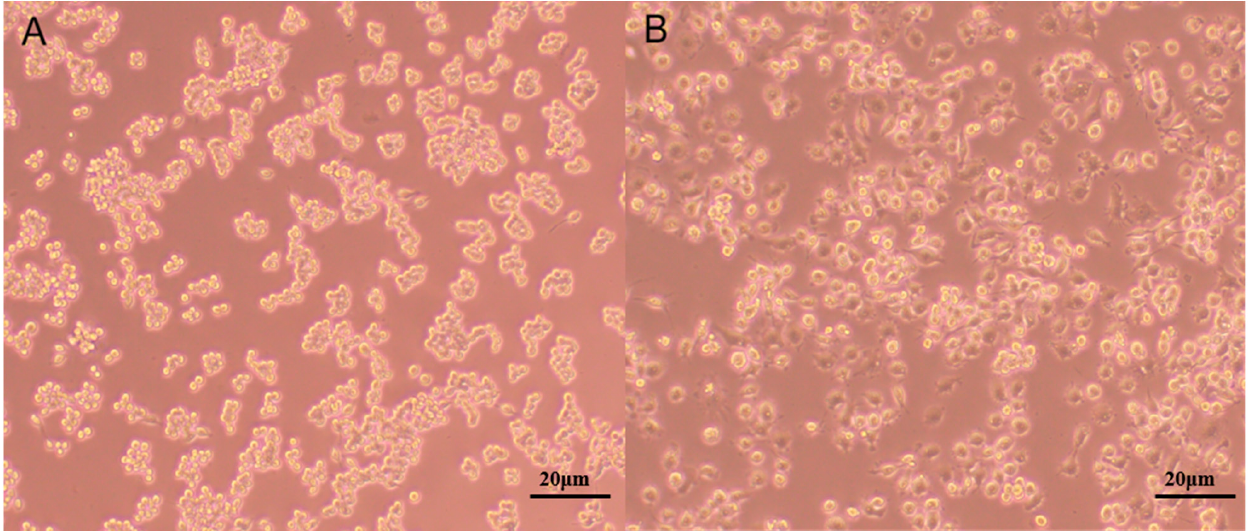
Figure 4. DPPH radical scavenging activity of PPL-1. Vcis the positive control group.